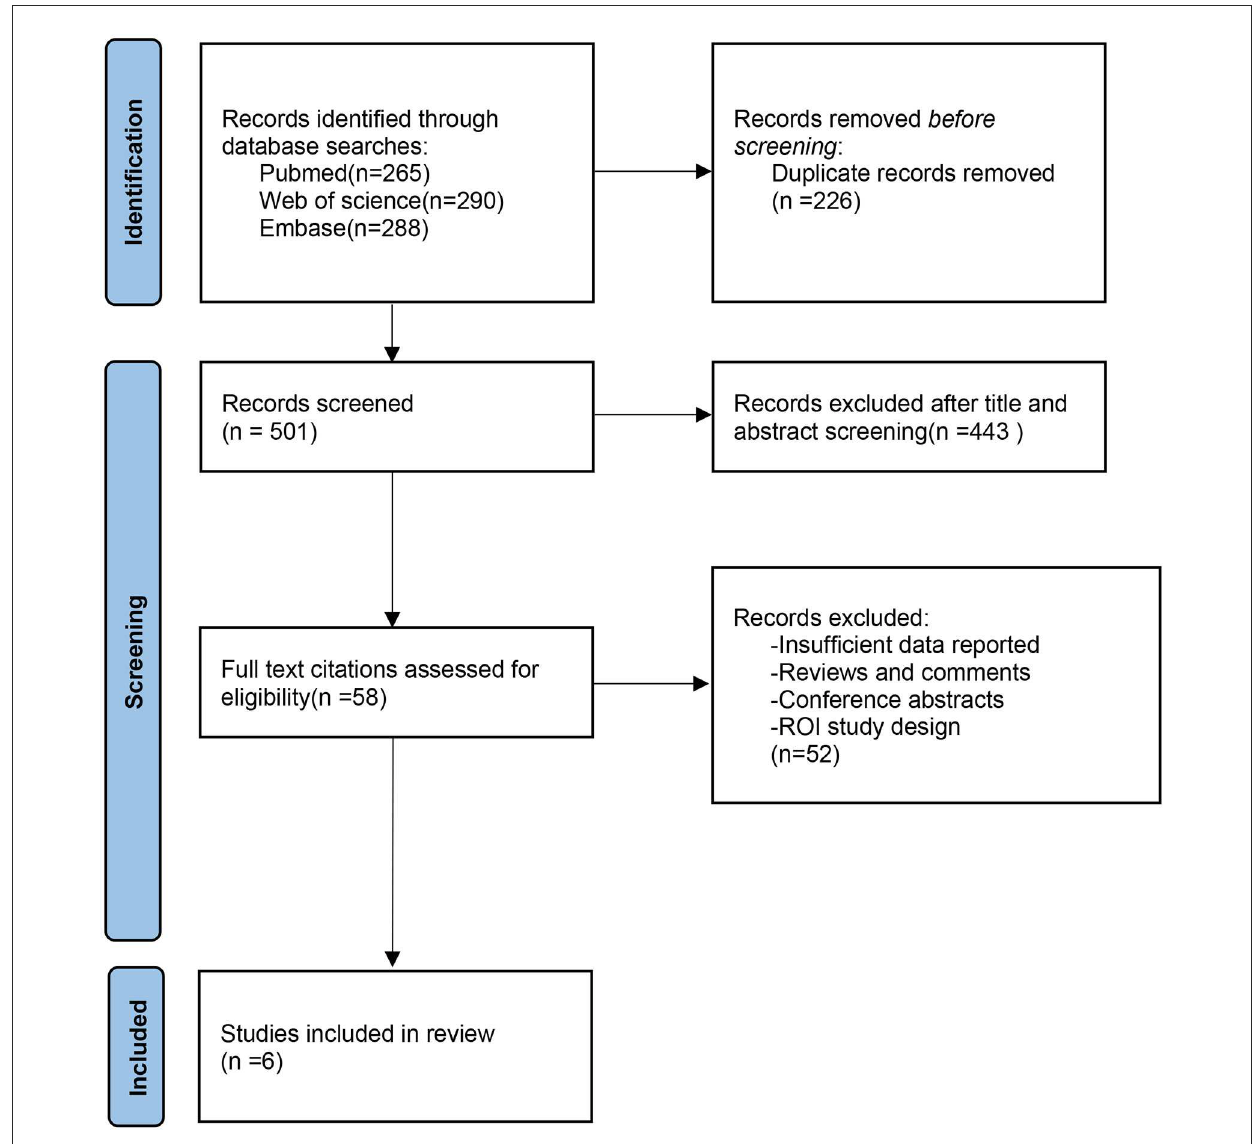
FIGURE1 PRISMA flow diagram representing screening and selection procedure in meta-analysis.